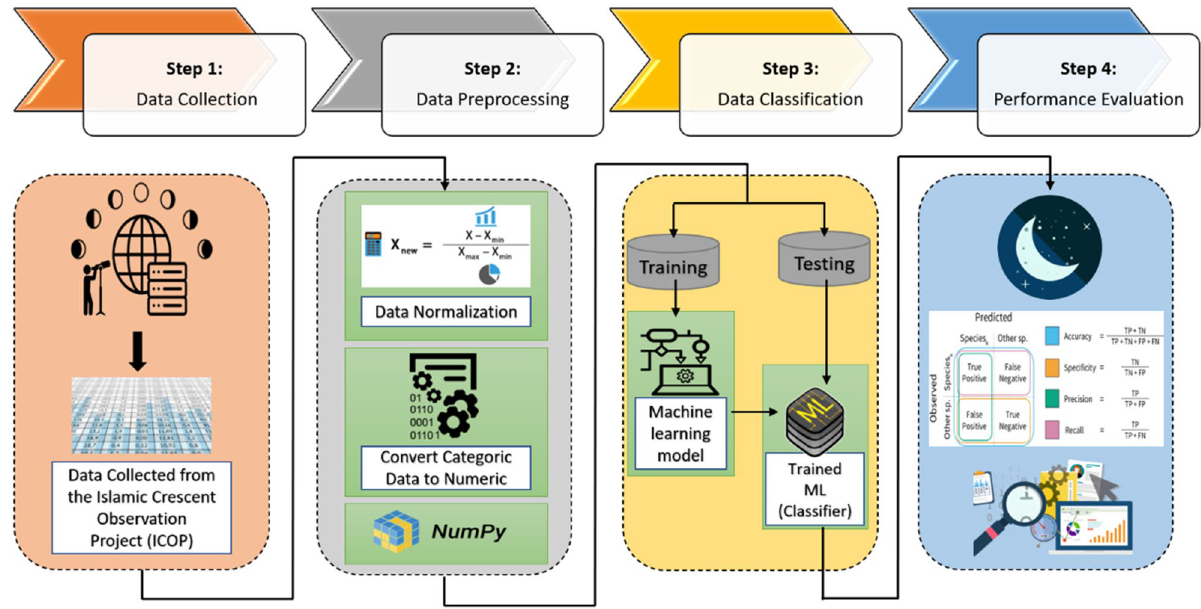
Figure 6. Steps followed in our